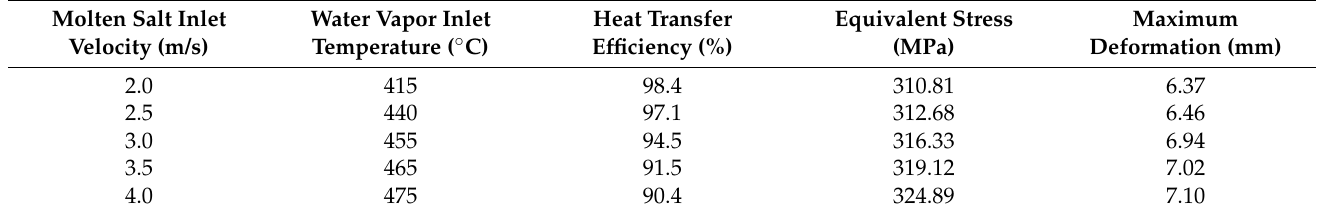
Table 6. Heat exchanger inlet and outlet parameters and stress distribution characteristics under different molten salt flow